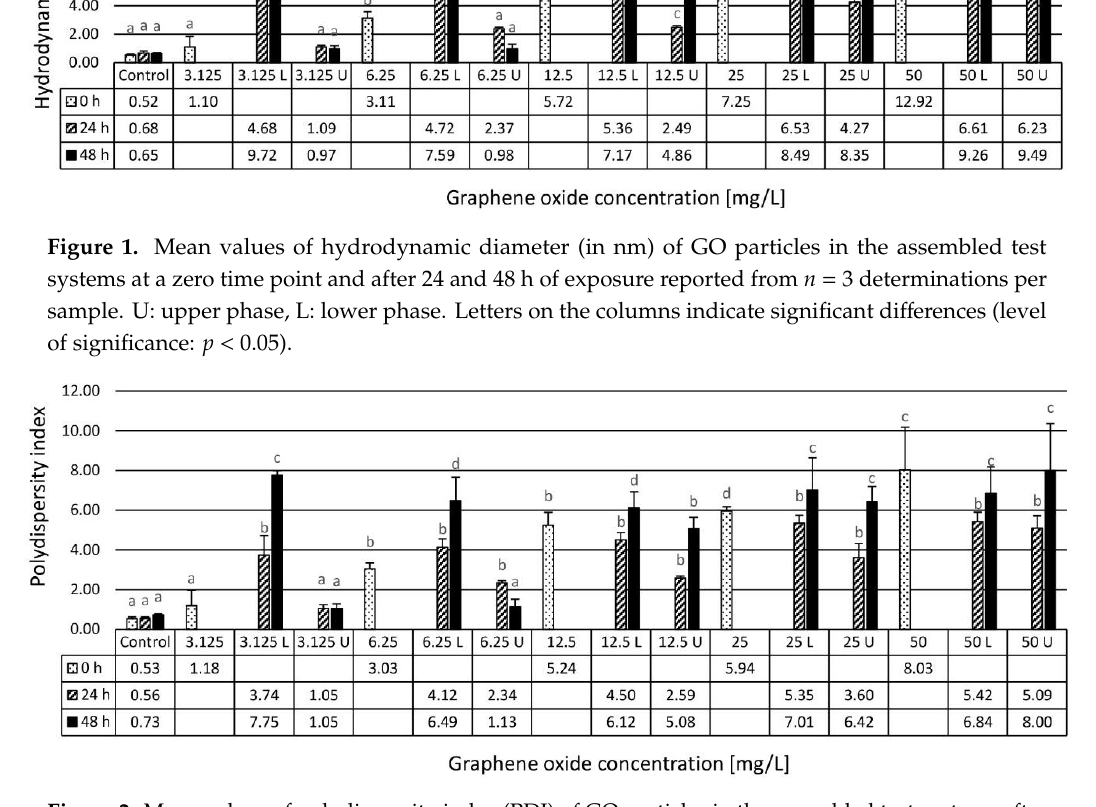
Figure 2. Mean values of polydispersity index (PDI) of GO particles in the assembled test systems after 24-h and 48-h of exposure reported from n = 3 determinations per sample. U: upper phase, L: lower phase. Letters on the columns indicate significant differences (level of significance: p < 0.05).